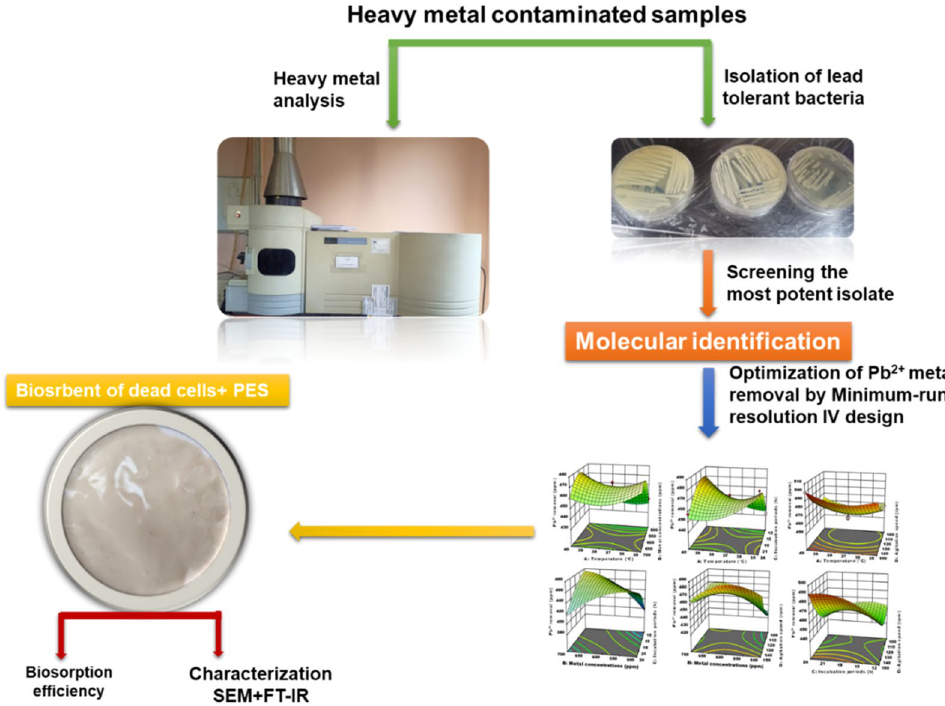
Figure 1. Graphical abstract for lead- tolerant bacteria under investigation.